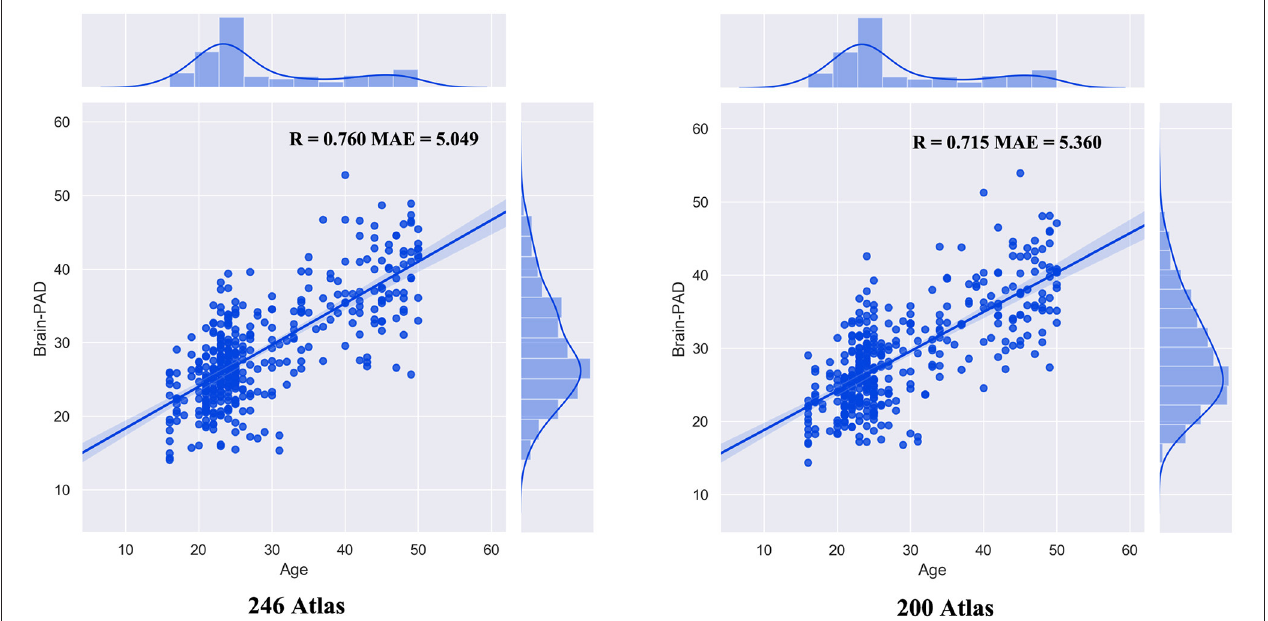
FIGURE 1 | The performance of the prediction